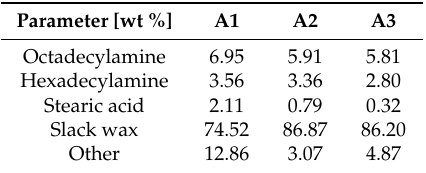
Figure 3. Chromatograms of slack wax.